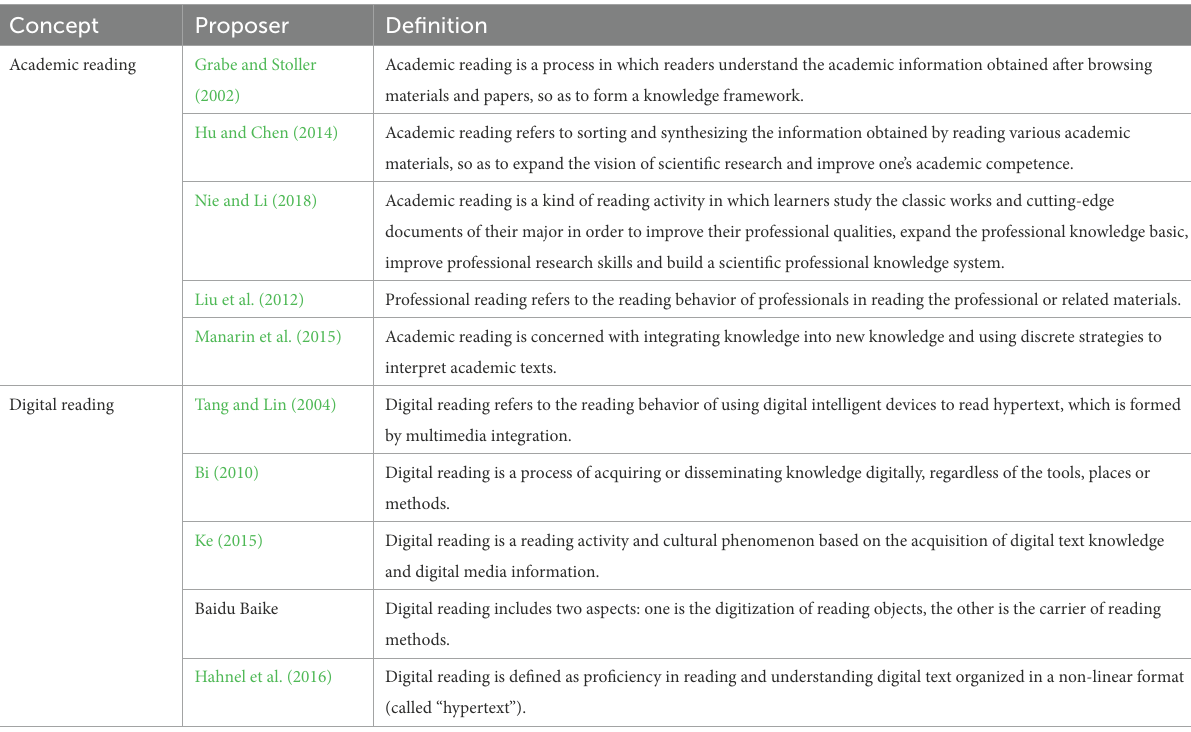
TABLE 1 Conceptual overview of digital reading and academic